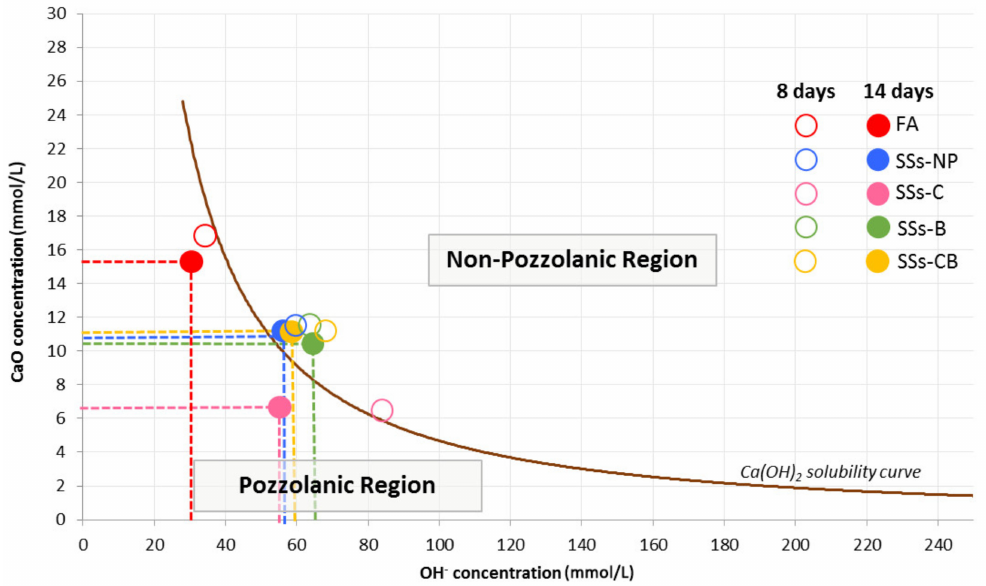
Figure 4. Result of Frattini test at 8 and 14 days of FA and SSS. SSS with different treatments applied showed negative pozzolanity at 8 and 14